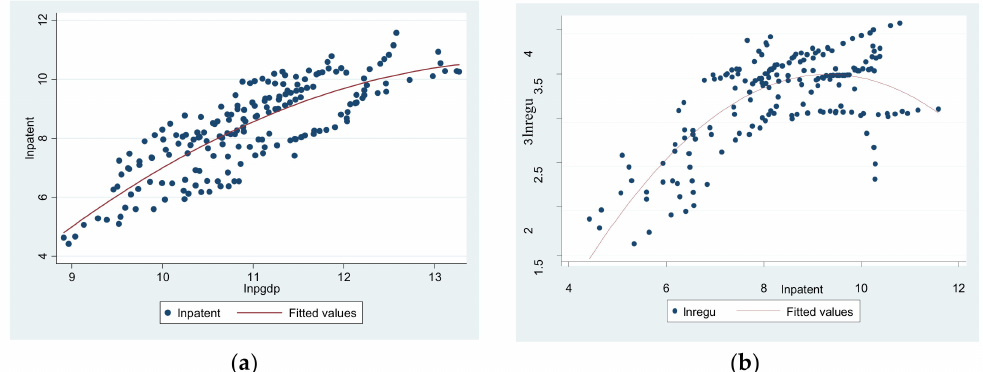
Figure 2. ( a ) The relationship between economic development and innovation. ( b ) The relationship between innovation and environmental